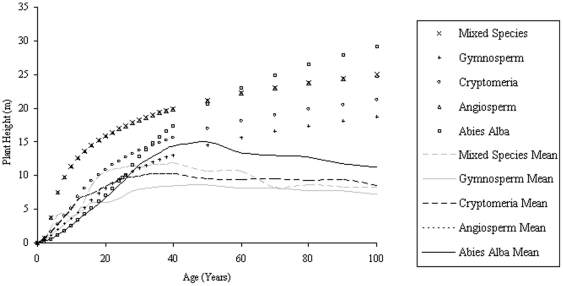
Hmax within forests of initial planting density of 10000 stems ha.−1 plotted alongside Hmean values where indicated in the legend.